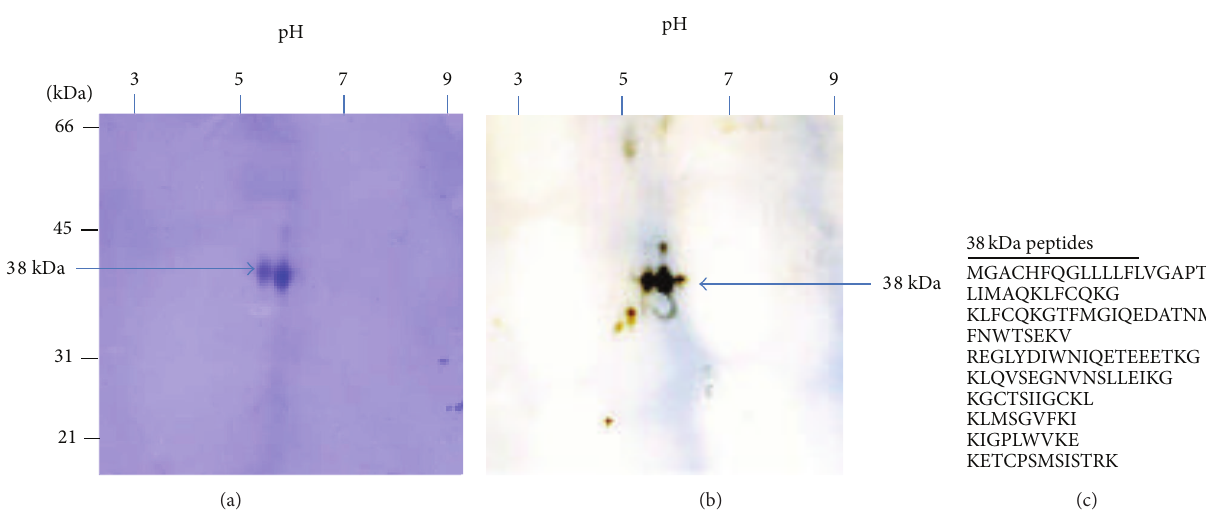
Figure 4: (a) and (b) purified fraction of RCA-agarose column fractionated by two-dimensional polyacrylamide gel electrophoresis stained with Coomassie Brilliant blue R (a) exhibited two distinct spots (38kDa) with pI of 5.4–5.8. Both spots were excised and identified by proteomic analysis. Western blot of same fraction stained with biotinylated RCA (b) reveals three isoelectric variants of 38 kDa polypeptide in the pH range 5.3 to 5.8. (c) Tryptic peptides of the 38 kDa polypeptide identified by MALDI-TOF-TOF proteomic analysis.